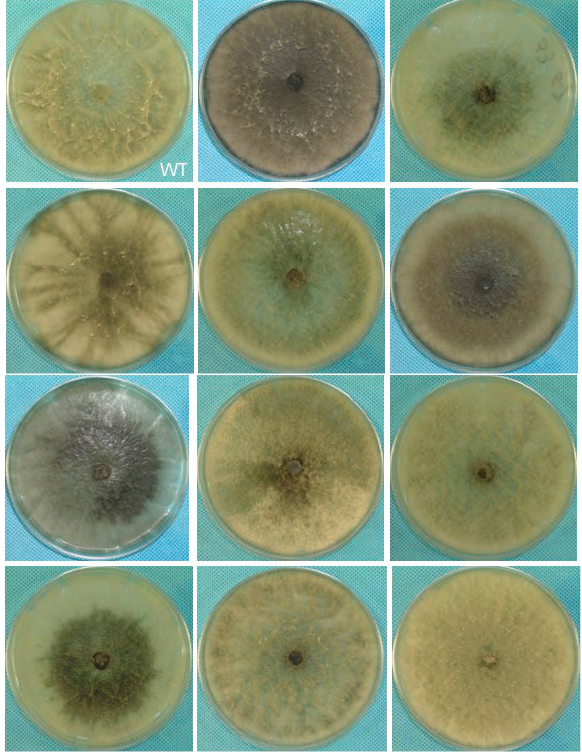
Figure 3. Different phenotypes of REMI transformants of Lasiodiplodia theobromae. Legend: WT, wild-type JZB 0300251 strain; the other images are of transformants gen - erated by